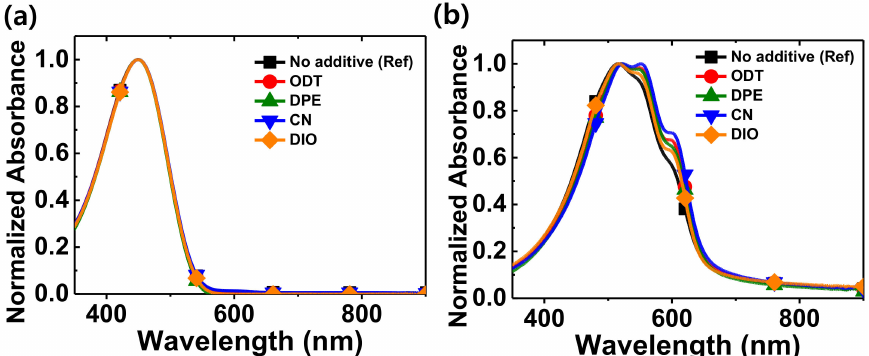
Figure 2. Normalized UV–Vis absorption spectra of P3HT at room temperature: ( a ) absorption in chloroform with and without additives. ( b ) Absorption of thin films processed with and without additives. The films were thermally annealed at 120 ◦ C for 30 min.